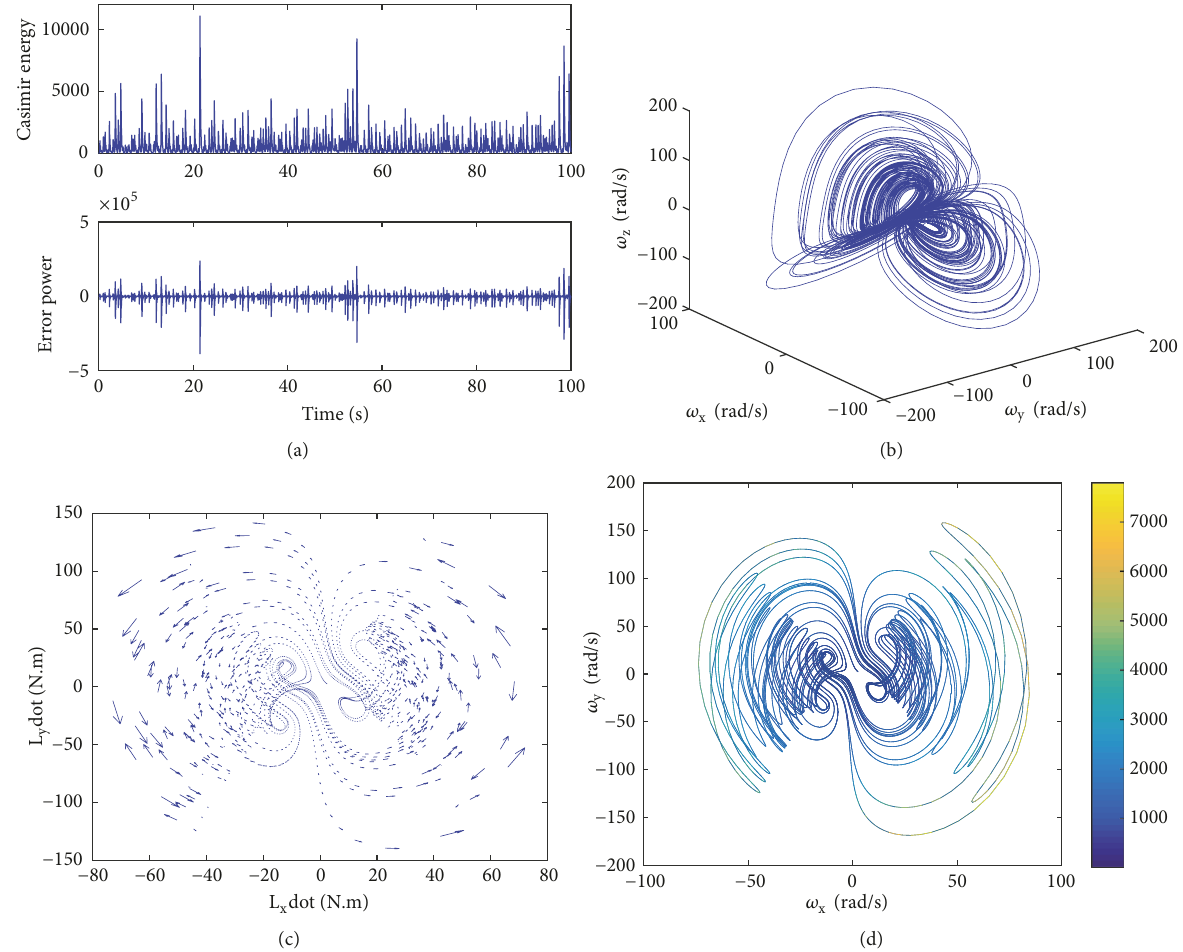
Figure 3: System governed by inertia, internal, and dissipative torques: (a) Casimir energy and Casimir power, (b) four-wing chaotic orbit, (c) phase plane of force field, and (d) phase plane orbit along with flowing Casimir energy.